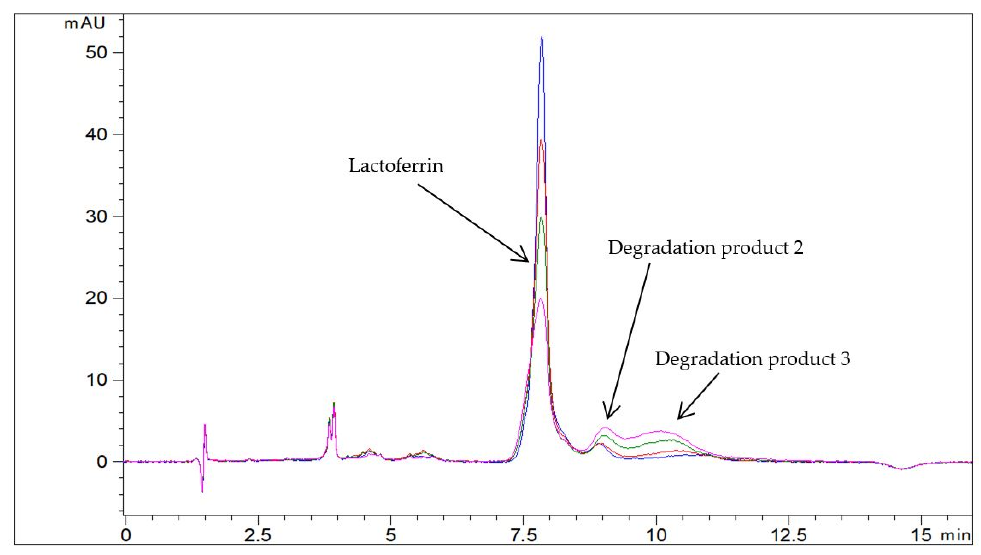
Figure 2. Representative chromatograms of Jarrow Formulas capsules with Lf in Milli-Q water (c = 1.0 mg/mL) at 60 °C at different time points: −− t = 0 min, −− t = 15 min, −− t = 30 min, and −− t = 60 min (RP-HPLC method).